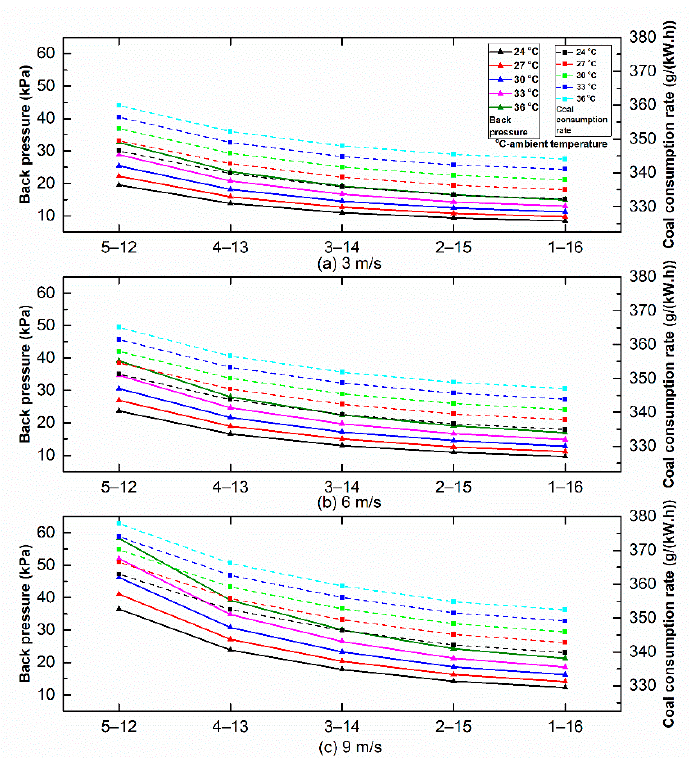
Figure 7. Variations of the back pressure and coal consumption rate in different operation strategies under ambient